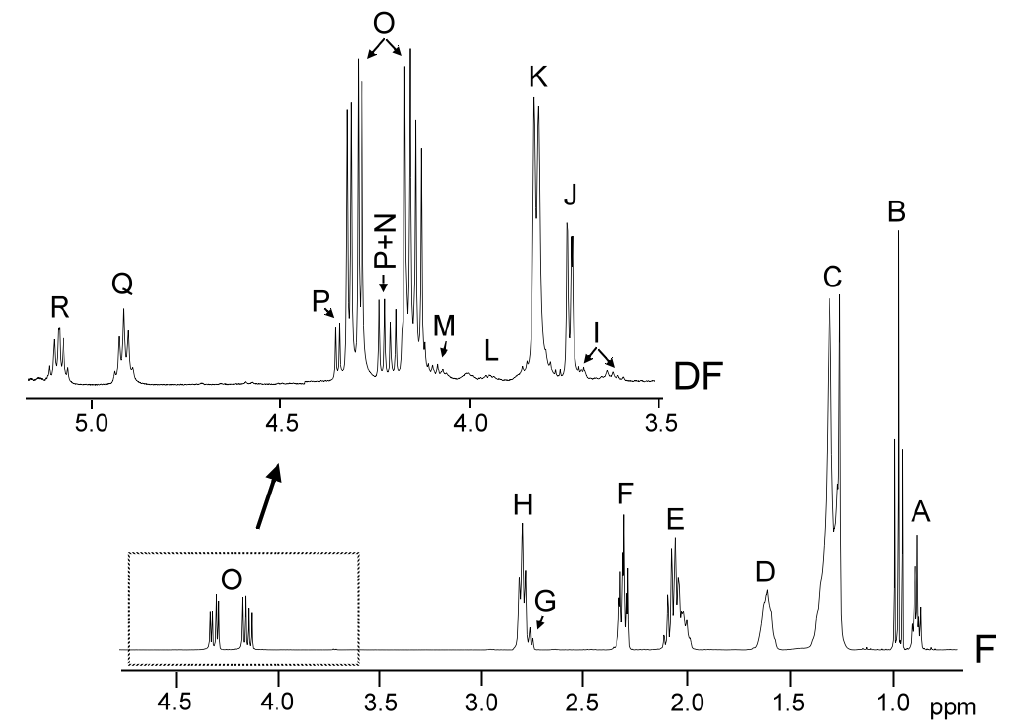
Figure 1. Region between 0.0 and 4.9 ppm of flaxseed virgin oil, F, 1 H NMR spectrum, and enlargement of the region between 3.5 ppm and 5.10 ppm of the 1 H NMR of the lipid extracted from the digestate, DF. The signal letters agree with those of Tables S2 and S3 of Supplementary Material.